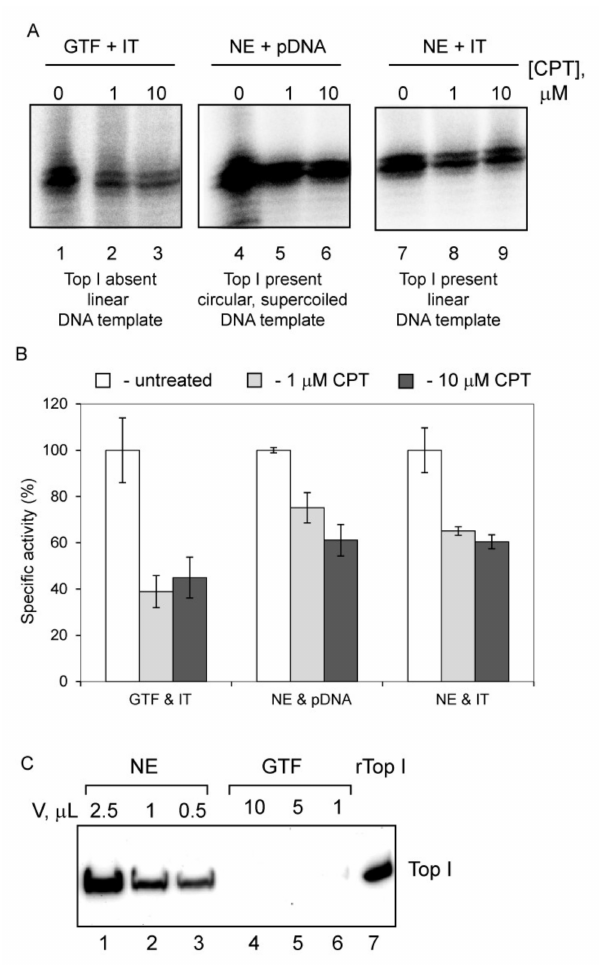
Figure 7. CPT treatment leads to inhibition of Pol-I transcription even in transcription reactions were Top 1 is not present or not required for transcription. ( A ) In vitro transcription reactions were supplemented either with 200 ng immobilized Pol-I promoter (left and right panels) or with 200 ng supercoiled plasmid DNA containing Pol-I promoter (central panel). Reactions were carried out in the presence of either purified GTFs capable of only a single round of transcription and lacking Top 1 (left panel) or HeLa NE capable of multi-round transcription and containing Top 1 (central and right panels). Efficiency of specific transcription was analyzed by S1 Nuclease protection assay and representative images are shown. ( B ) The results were quantified with aid of a phosphoimager. The data expressed as a percentage of the highest value (set at 100%). The data represents an average from three independent experiments ( n = 3); standard deviations are shown; p -values were calculated using one and two-way ANOVA on R software, p < 0.05. ( C ) Top 1 is absent in highly purified transcription factors. Various quantities of NE and GTF (as indicated) were analyzed by Western blotting using antibodies against human Top